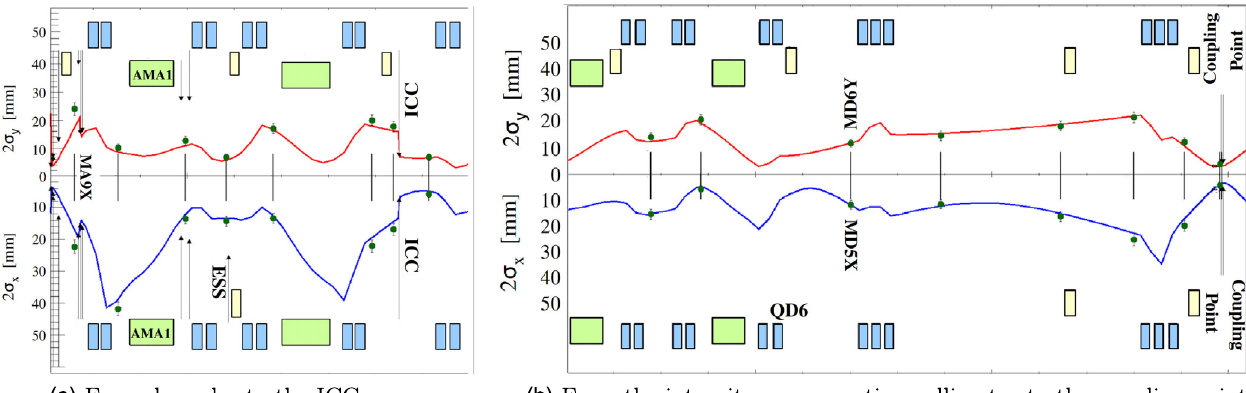
FIG. 9. 2 σ envelope at 230 MeV from the degrader up to the coupling point of the Gantry 3. The red and blue lines represent the beam size from OPAL in the vertical and horizontal-(bending) plane, respectively. The green dots represent the measured 2 σ beam size after a cut of the lateral tails of the measured beam profile below 10%. The lattice is also drawn, in particular: monitors (vertical black lines), collimators (vertical arrows), dipoles (light green box), quadrupoles (light blue box), and steering magnets (light